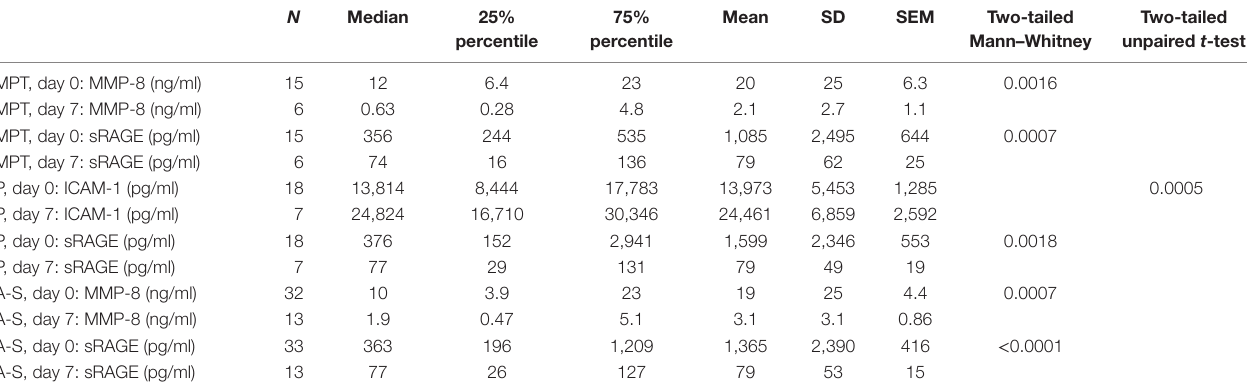
Table of within-treatment group statistical differences, comparing days 0 to 7 levels of MMP-8, sRAGE, and ICAM-1. Day 0 compared to day 7 levels of PAI-1 and angiopoietin-2 did not differ. Methylprednisolone group (MPT), placebo group (P), all subjects (A-S), SD, and